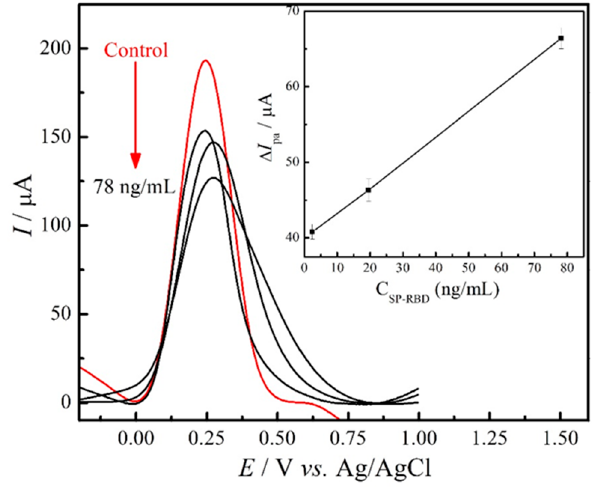
Figure 5. SWV data of the immunosensor in the absence (control) and presence of spike protein RBD concentrations ranging from 2.44 to 78 ng/mL; the inset shows the relationship between the Δ I pa and concentration of the SARS-CoV-2 spike protein.